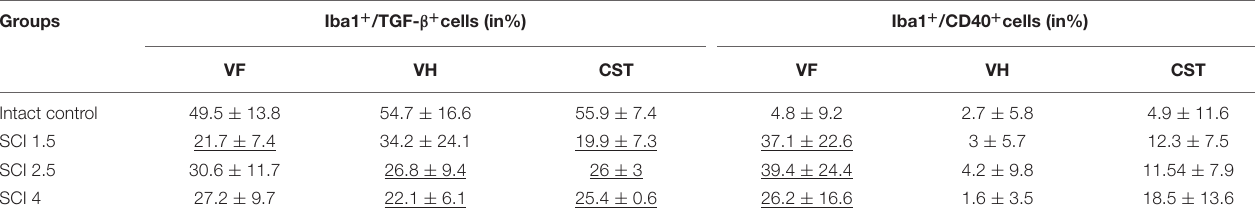
The underlined data indicate significance has been reached (p < 0.05) when compared to the intact control